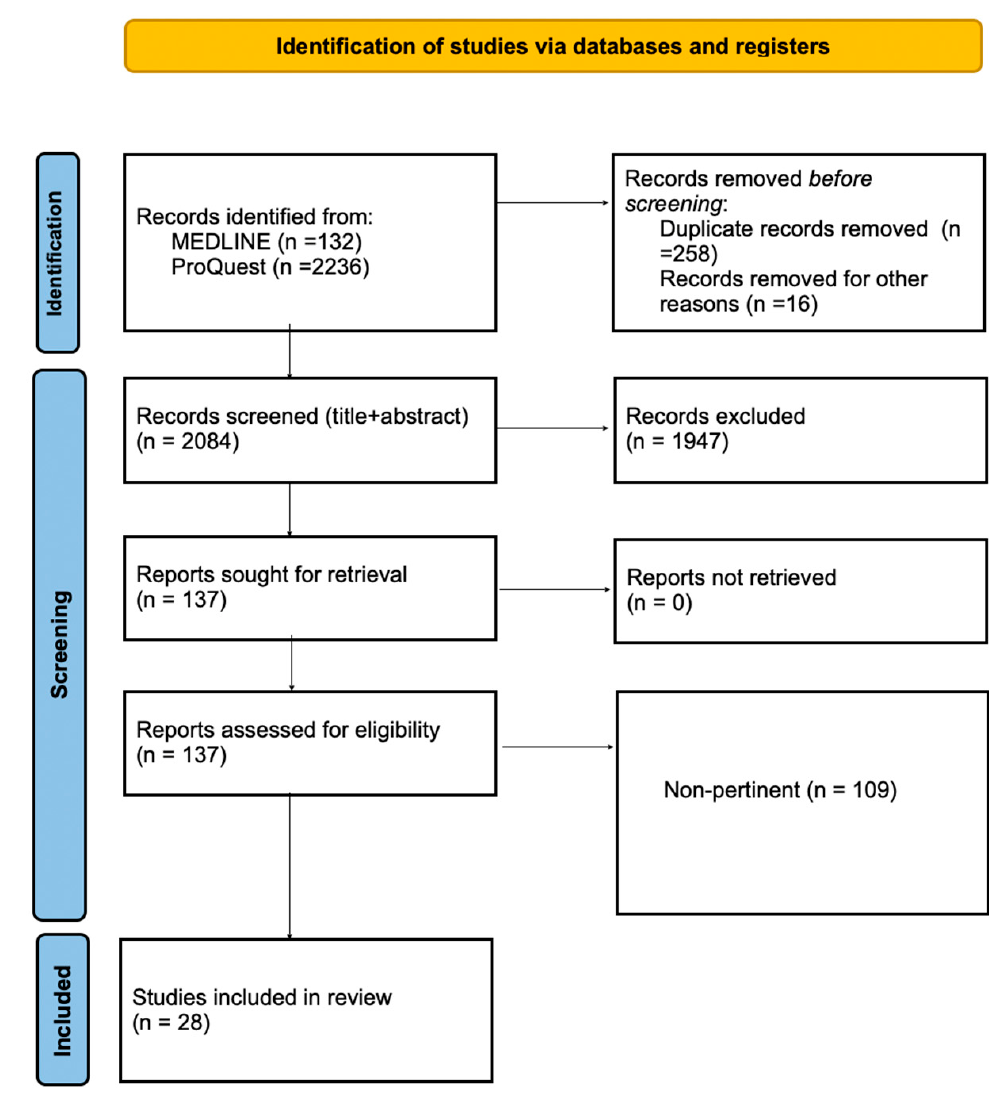
Figure 2. PRISMA Figure 2. PRISMA flowchart.